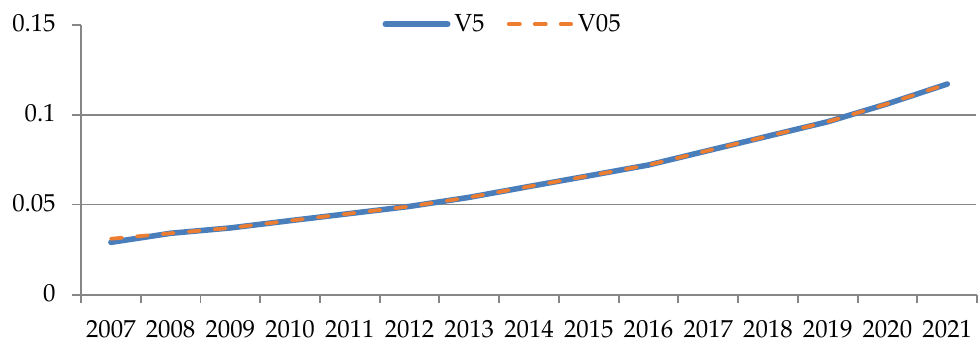
Figure 10. Graphs for tracking the target revenue indicator for industry No. 4 (author’s results).